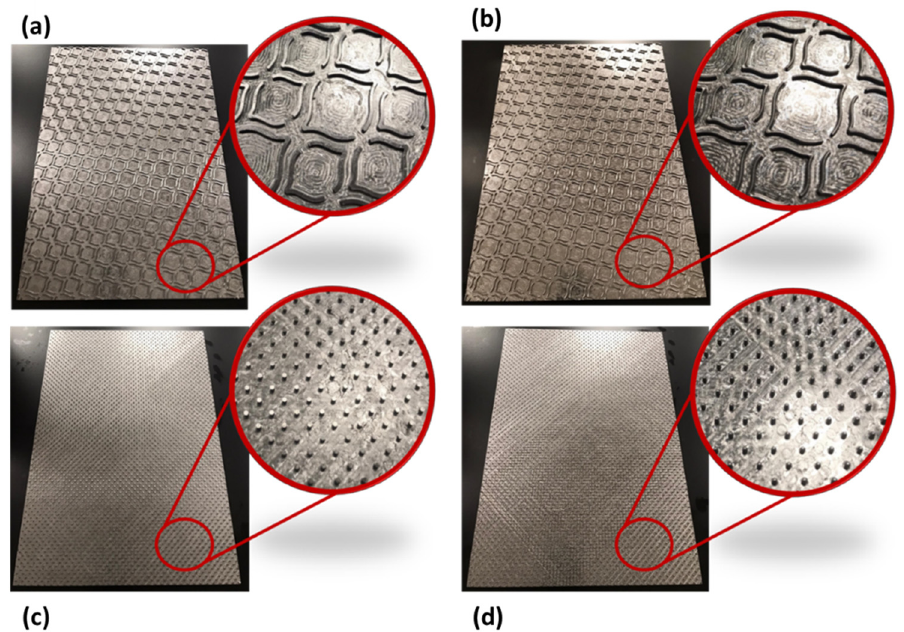
Figure 2. Images of the 3D steel embossing plates with the deco pattern and micropattern, and details of the respective finishing geometries: ( a ) deco pattern with straight lines, ( b ) deco pattern with round lines, ( c ) micropattern with straight dots, and ( d ) micropattern with round dots. All the tissue samples are denominated according to each 3D steel-plate pattern and finishing geometry. Samples embossed with the deco pattern with straight lines are designated by adding the abbreviation d sl to the paper denomination, and those with round lines are designated by d rl . The samples embossed with the micropattern with straight dots are designated by adding the abbreviation m sd to the paper denomination, and those with round dots by m rd .